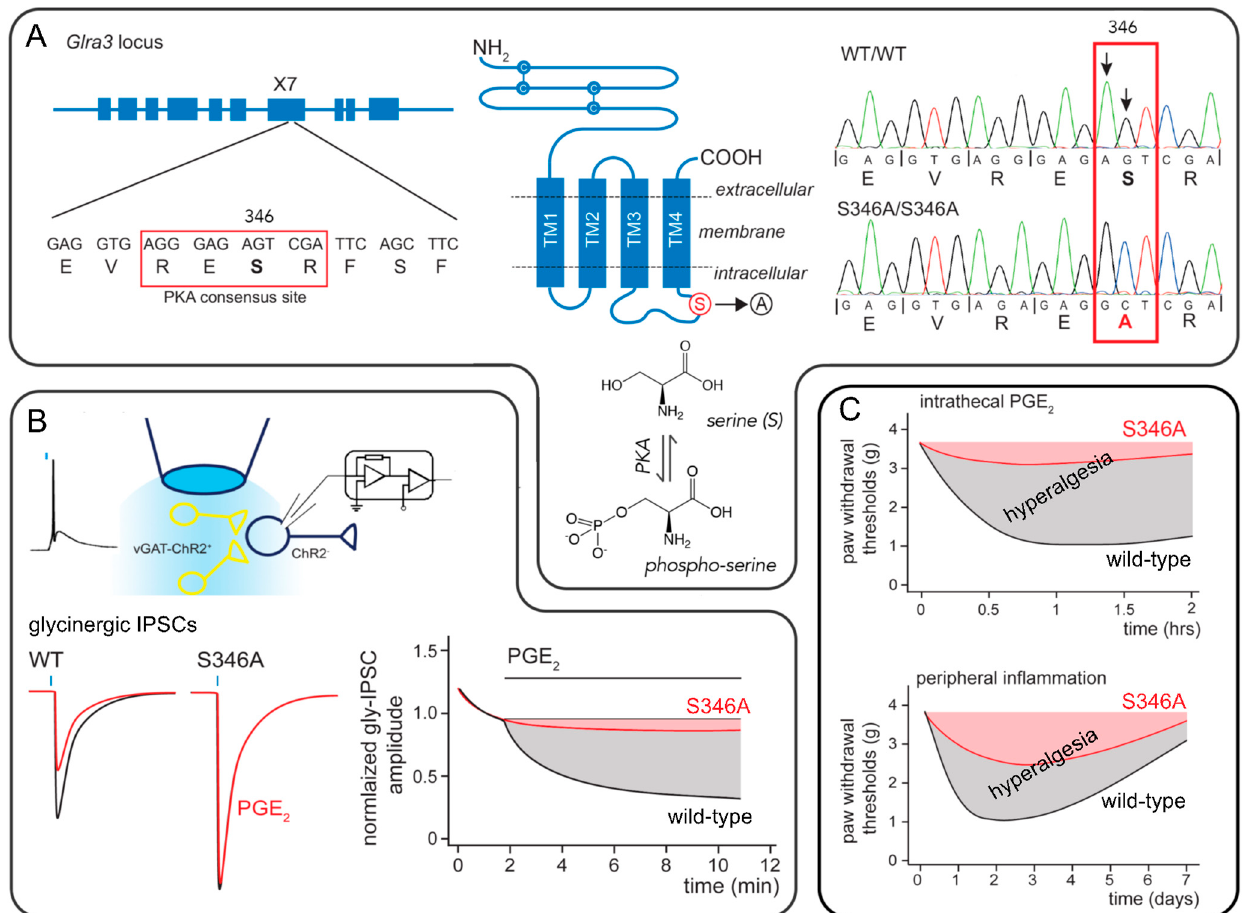
Figure 2. PKA-dependent phosphorylation on α 3 GlyRs. ( A ) Left: Exon 7 (X7) of the Glra3 gene contains a DNA sequence encoding for a strong consensus site for PKA-dependent phosphorylation. Middle: This site consisting of the four amino acids RESR (positions 344-347) is located in the long intracellular loop of the α 3 subunit. Mutation of serine at position 346 (S346) to an alanine prevents phosphorylation at this site. Left: CRISPR-Cas technology was used to introduce this mutation (S346A) into the genome of mice. Pherograms showing the DNA sequencing results of the part of X7 that contains the PKA consensus site in wild-type mice and homozygous S346A point mutated mice. ( B ) Top: Patch-clamp recordings were made for excitatory neurons in spinal cord slices obtained from wild-type and homozygous S346A point mutated mice, which both carried a channelrhodopsin-2 transgene expressed in inhibitory neurons for optogenetic activation. Brief pulses of blue light evoke action potentials in inhibitory neurons and as a consequence inhibitory postsynaptic currents (IPSCs) in synaptically connected neurons. Bottom left: Glycinergic IPSCs were inhibited by PGE 2 in wild-type but not S346A mice. Right: Time course of the amplitudes of normalized glycinergic IPSCs before and during superfusion of the slices with PGE 2 . ( C ) Top: Hyperalgesia evoked by intrathecal injection of PGE 2 was completely absent in S346A point mutated mice. Bottom: Hyperalgesia triggered by subcutaneous injection of the yeast extract zymosan A was strongly reduced in the point ‐ mutated mice.